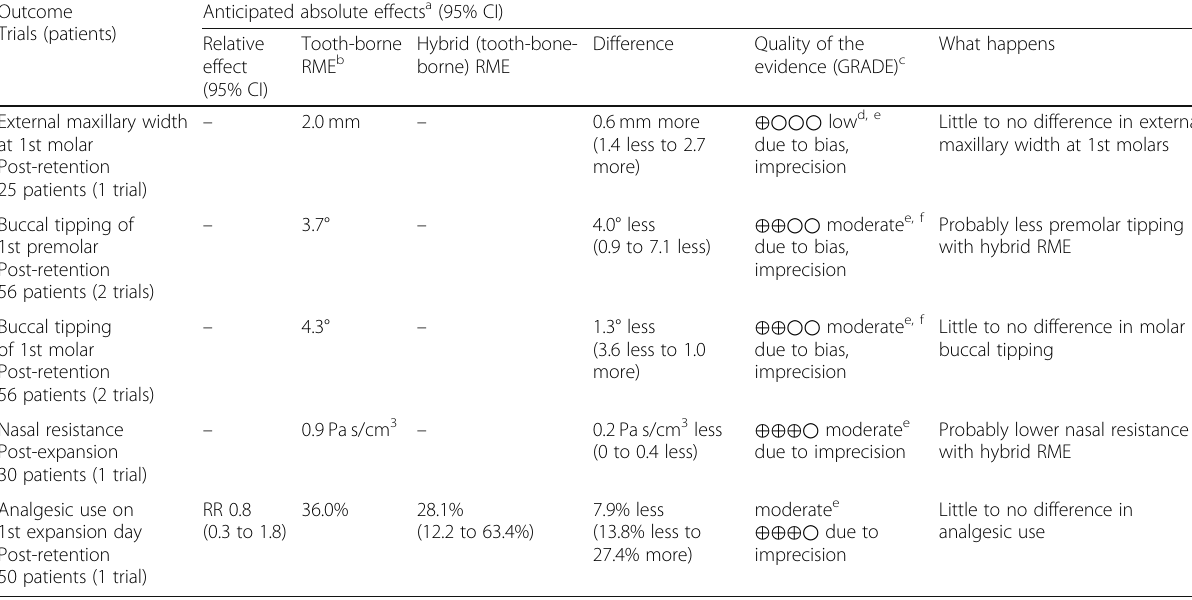
Table 5 Summary of findings table according to the GRADE approach for the comparison of hybrid (tooth-bone-borne) versus tooth-borne rapid maxillary expansion Outcome Trials